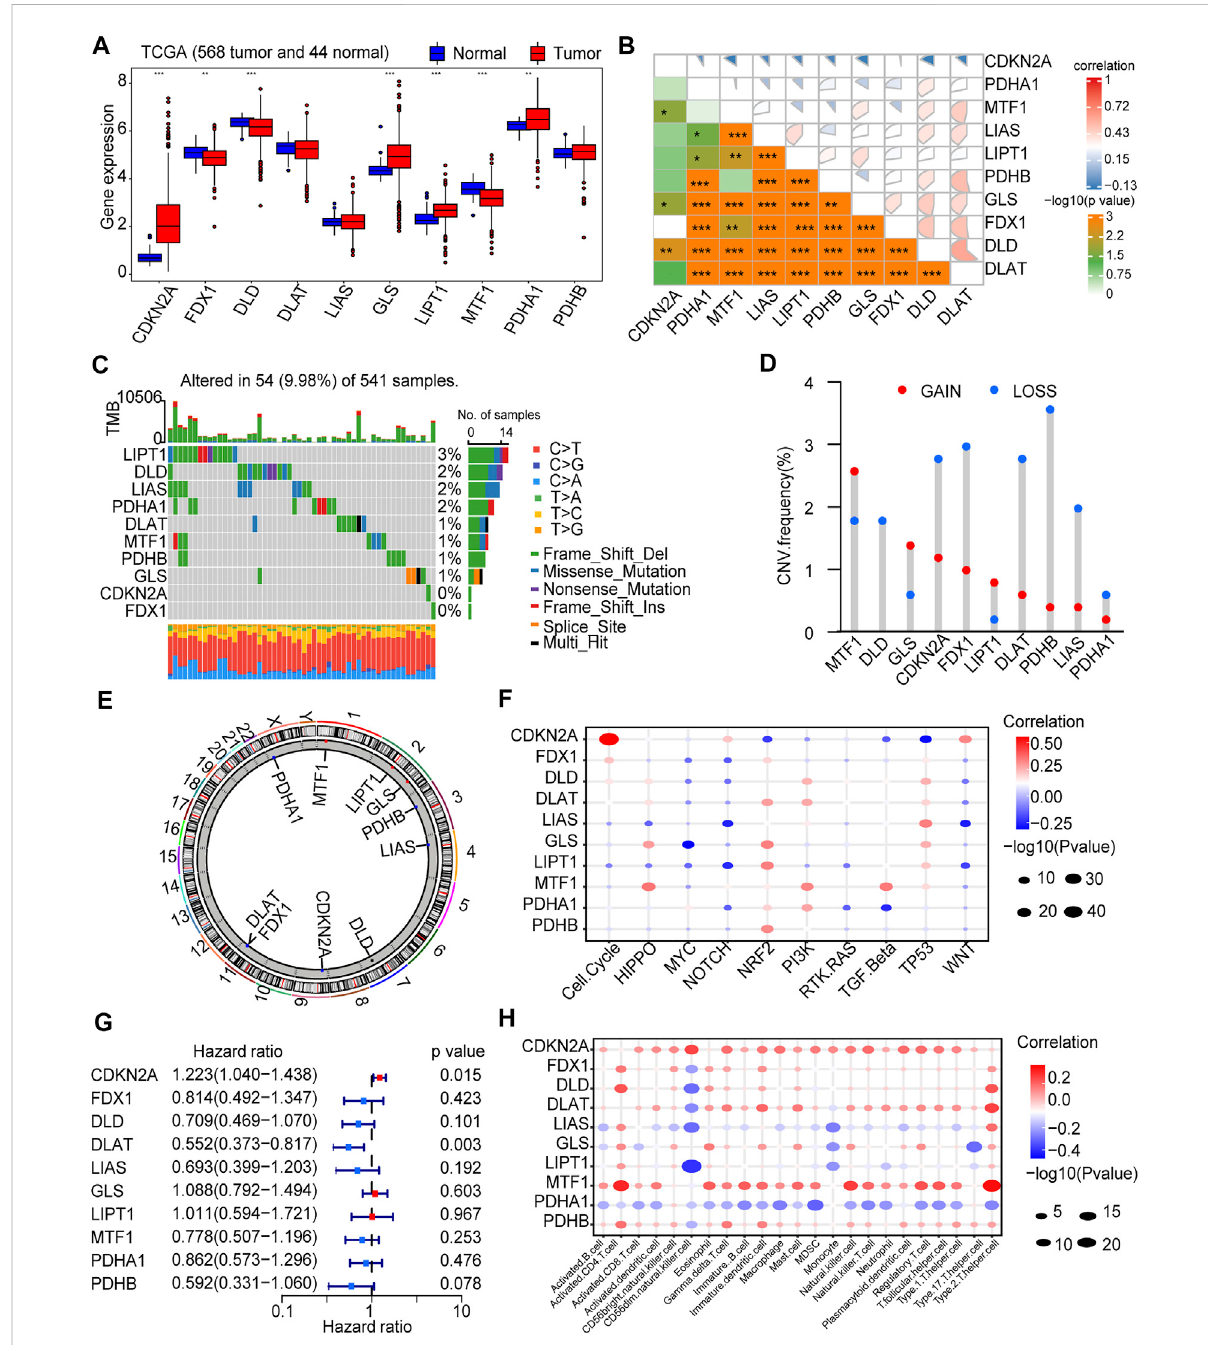
FIGURE 1 Landscape of Cuproptosis-related Genes (CRGs) in CRC. (A) Expression of CRGs in colorectal tumor tissues and adjacent non-tumor tissues from TCGA-COAD and TCGA-READ (612 patients: 568 tumor and 44 normal). (B) Correlation between CRGs expression. (C) Gene mutation of CRGs. (D) Copy number variation (CNV) frequency of CRGs. (E) The location on the chromosome where CRGs CNV changes. (F) Correlation between CRGs and CRC important initiation and progression mechanisms. (G) Univariate COX regression analysis of the hazard ratio between CRGs and CRC overall survival. (H) Correlation of CRGs and immune cell in fi ltration. * p < 0.05, ** p < 0.01, *** p <